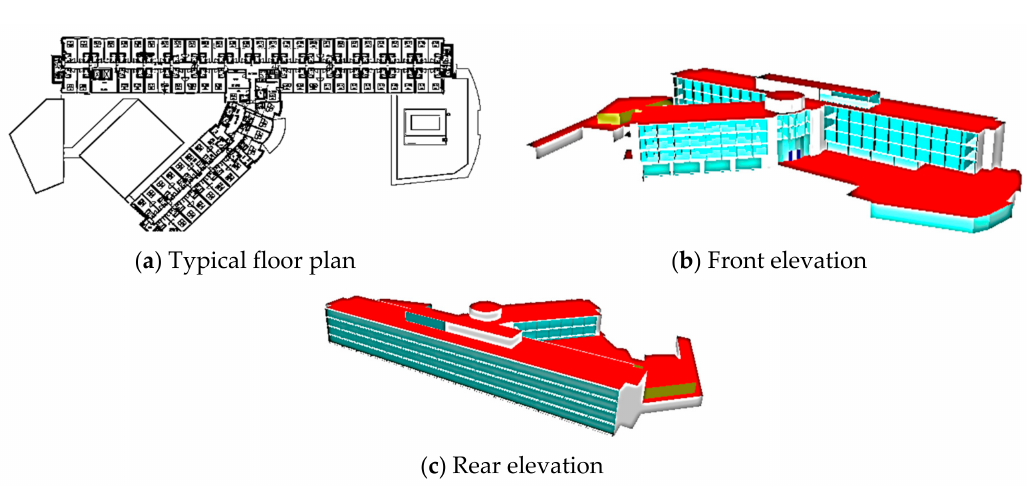
Figure 1. Typical floor plan and TAS 3D modelling results of the hotel